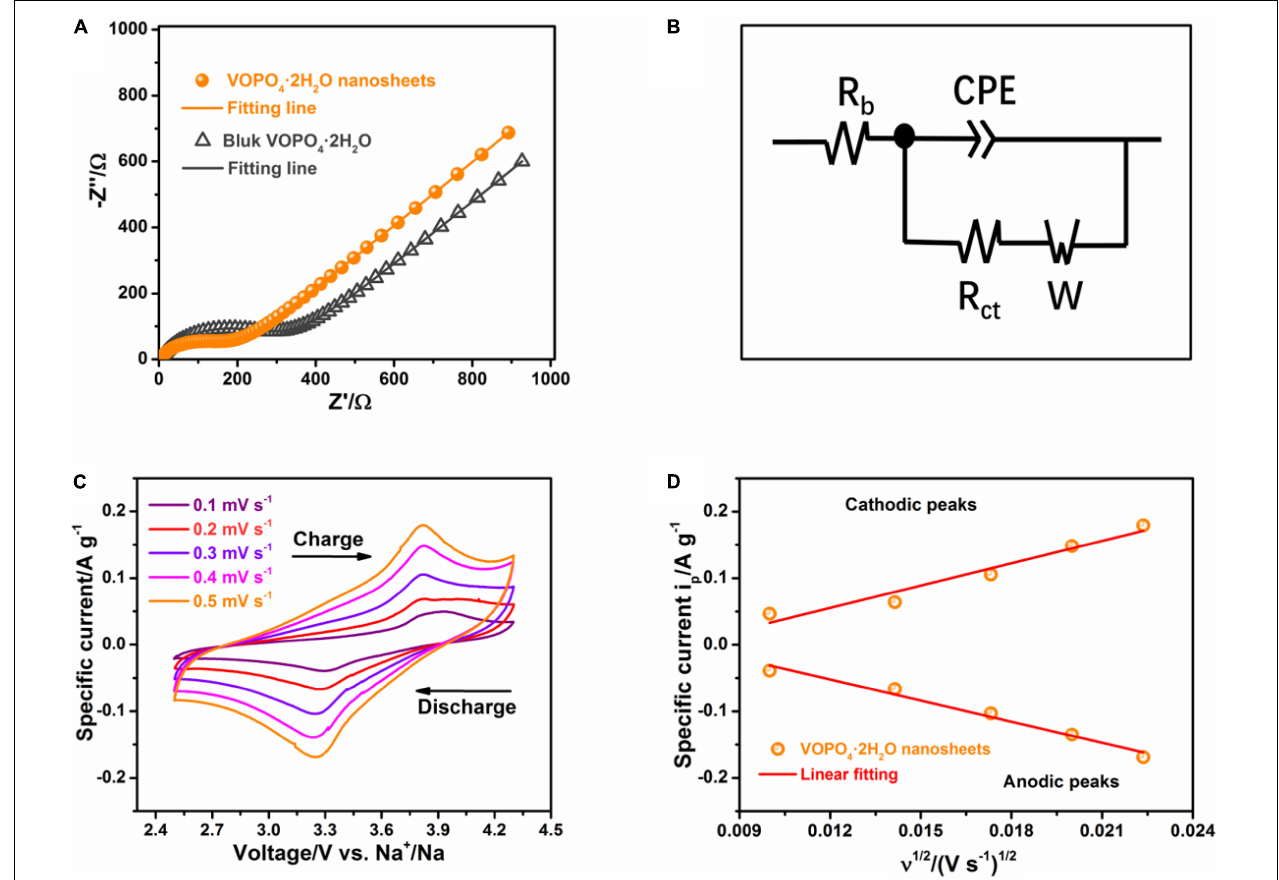
FIGURE 4 | Electrochemically kinetic analysis of the VOPO 4 · 2H 2 O nanosheets and bulk VOPO 4 · 2H 2 O. (A) Nyquist plots; (B) equivalent circuit model of the impedance spectrum; (C) CV profiles of the VOPO 4 · 2H 2 O nanosheets at 0.1–0.5 mV s − 1 , and (D) the linear relationship between the specific peak current and the square root of scan